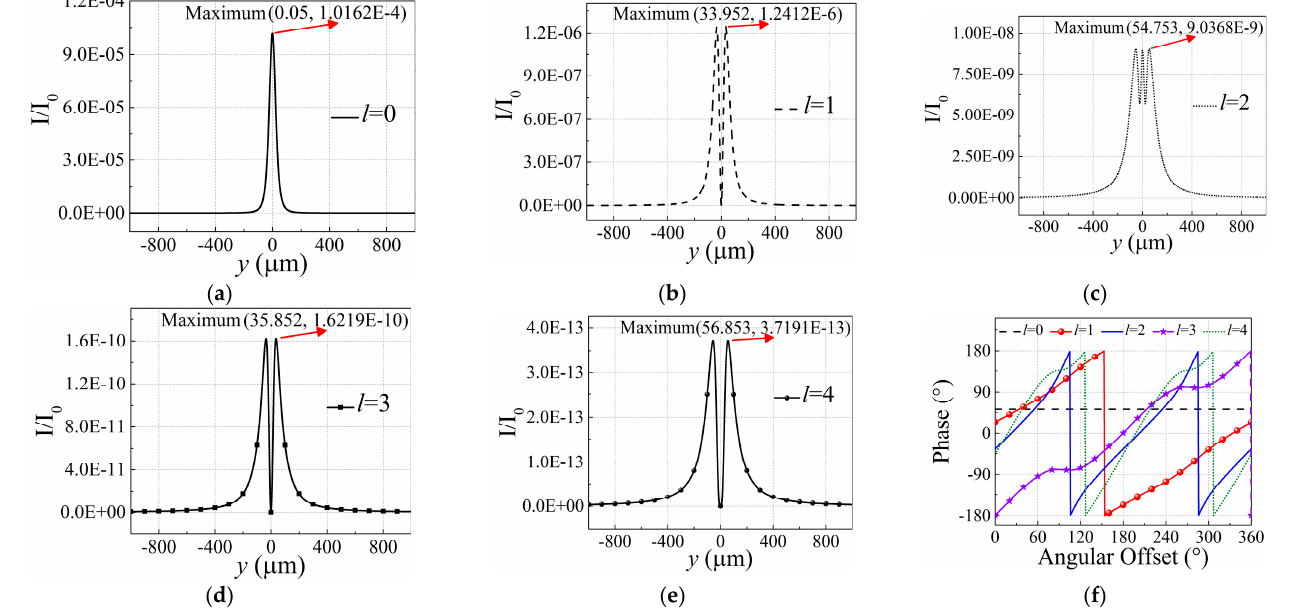
Figure 6. ( a – e ) present the one-dimensional intensity of the scattered field in the polarization direction, where the beam is incident with topological charges of 0–4; ( f ) is the phase sampling results along the circumference. The scatterer is a uniform and isotropic spherical particle, the measurement plane is located at z = 50 μ m.